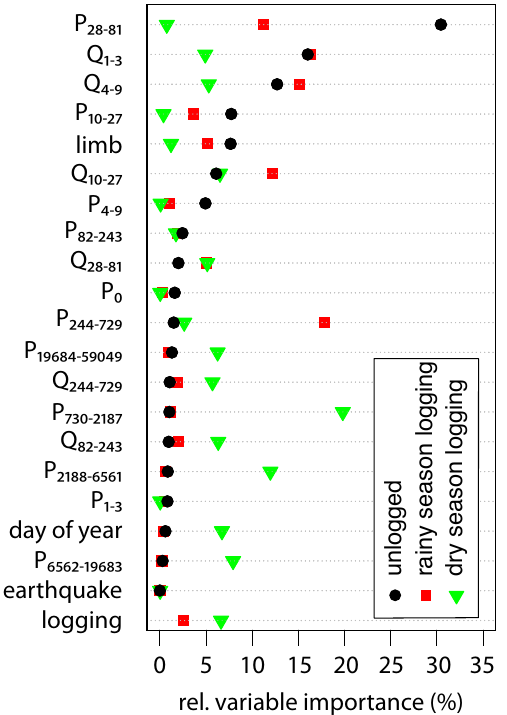
Figure 6. Variable importance of the quantile regression models for each catchment scaled to 100% in order to facilitate inter-catchment comparison. See Supplement Table 1 for predictor variables.